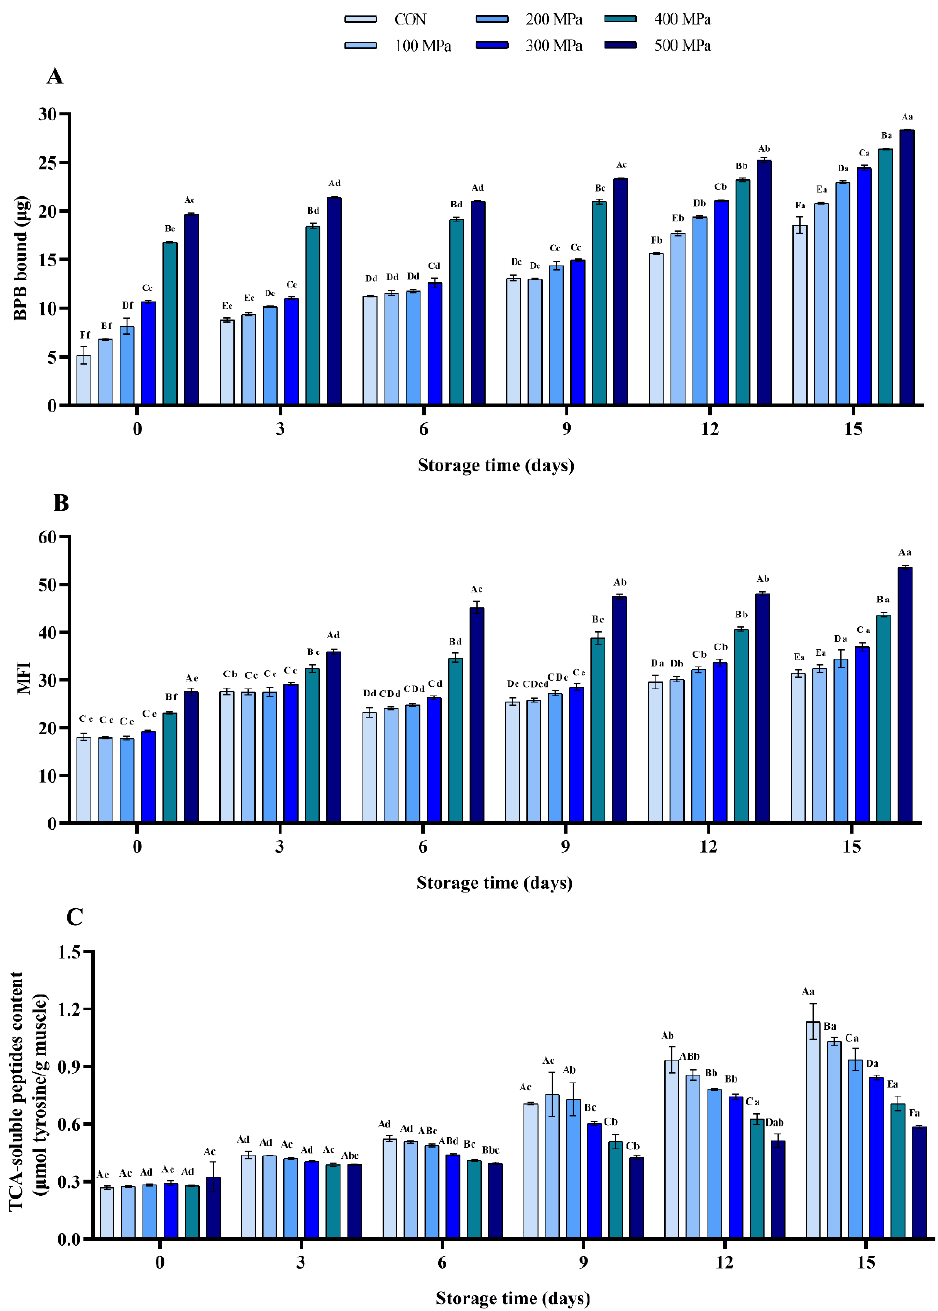
Figure 1. Effects of UHP treatment on protein degradation of shrimp during storage: the content of ( A ) surface hydrophobicity, ( B ) MFI, and ( C ) TCA-soluble peptides.